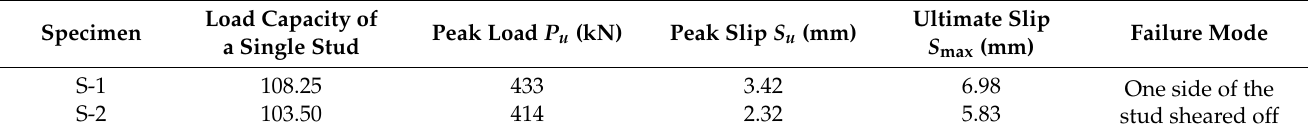
Table 4. Static loading test results of specimens.